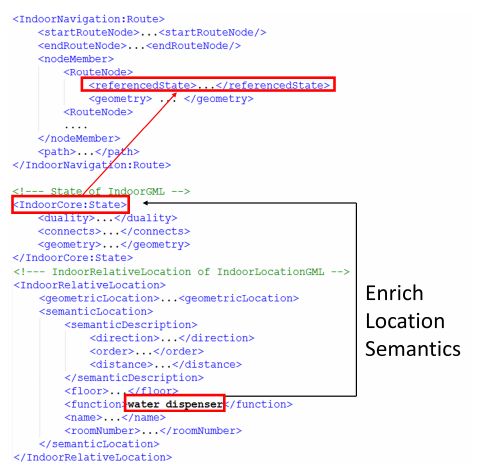
Figure 6. IndoorLocationGML provides detailed location semantics for Route